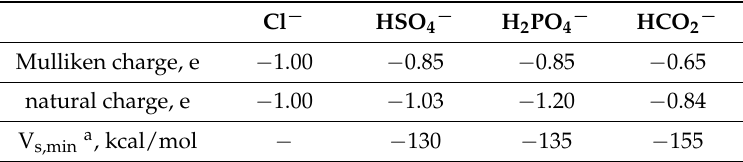
Table 7. Measures of negative charge on O/Cl atom interacting with Sn. 296